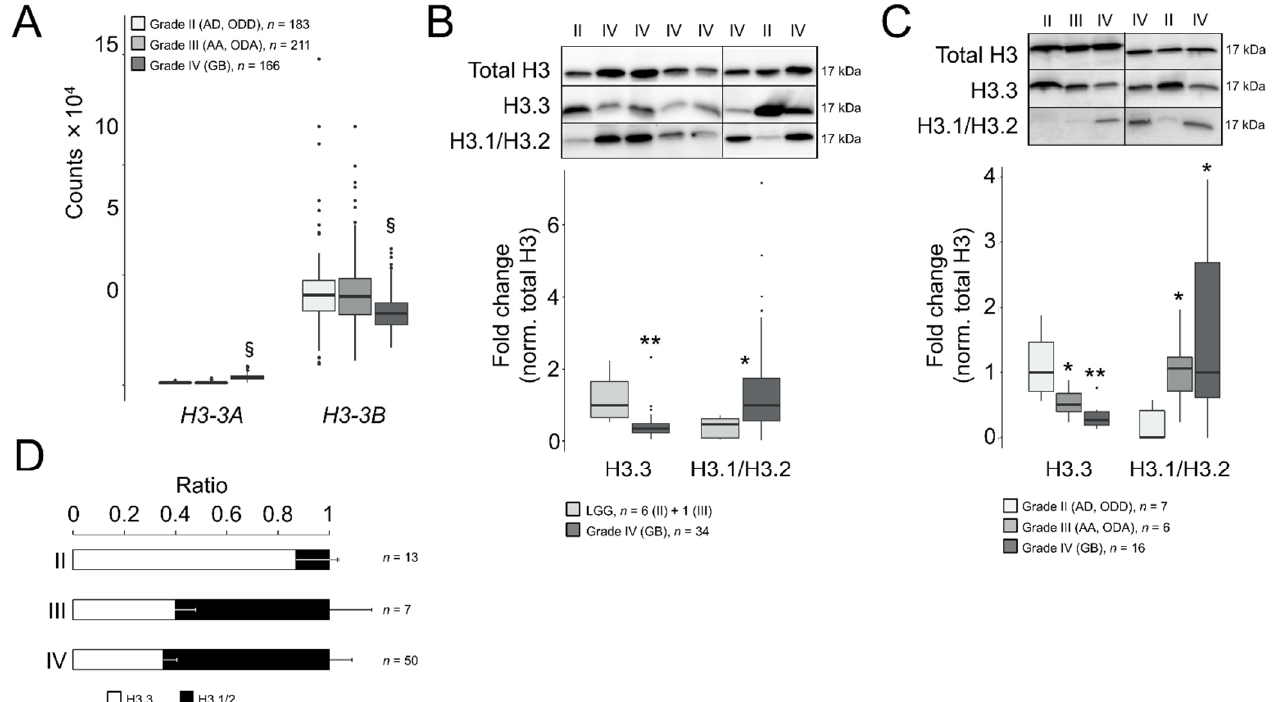
Figure 1. Differential ratios of H3.3 and the canonical H3 variants across gliomas of different grades. ( A ) Transcript levels of H3-3A and H3-3B in gliomas of TCGA database according to the RNA-seq analysis. Note: §, adjusted p < 0.005; negative binomial test. AD, diffuse astrocytoma; ODD, diffuse oligodendroglioma; AA, anaplastic astrocytoma; ODA, anaplastic oligodendroglioma; GB, glioblastoma. ( B ) Western blotting assays in surgical tumor resections of the first cohort: upper panel, representative crops of blots; lower panel, quantification. Only one sample was of grade III (OD) and was indistinguishable from grade II samples, therefore we pooled the data (LGG, lower-grade gliomas). Total H3, antibody against a common sequence epitope in histone H3 variants; H3.3, antibody CS207327; H3.1/2, antibody ABE154. Note: * p < 0.05; ** p < 0.005; Mann–Whitney U test related to LGG. ( C ) Western blotting assays in surgical tumor resections of the second cohort depicted as in ( B ). Note: * p < 0.05; ** p < 0.005; Mann–Whitney U test related to grade II gliomas. ( D ) Ratio of the H3.3 and H3.1/H3.2 values from both cohorts.